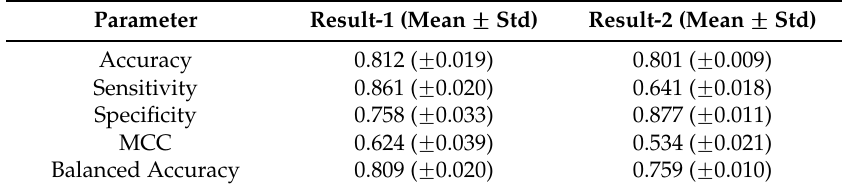
Table 2. Cross validation